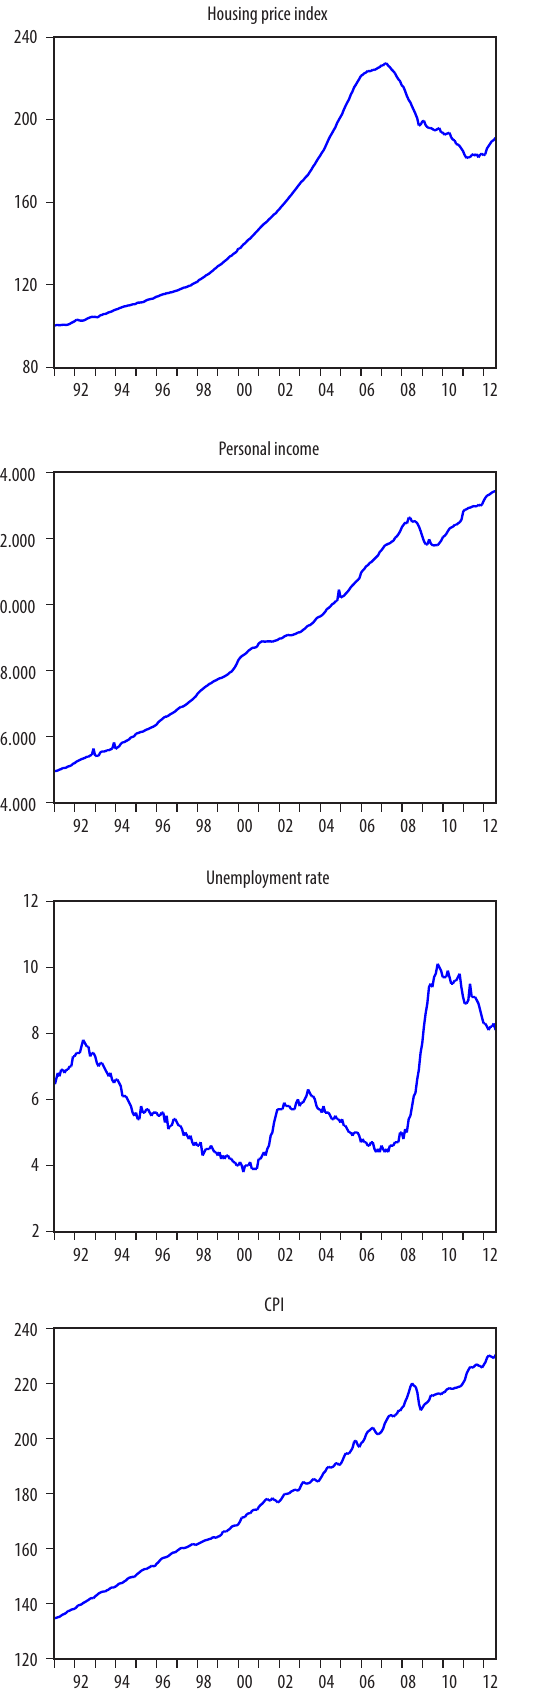
Fig. 1. Time series of house prices and macroeconomic variables